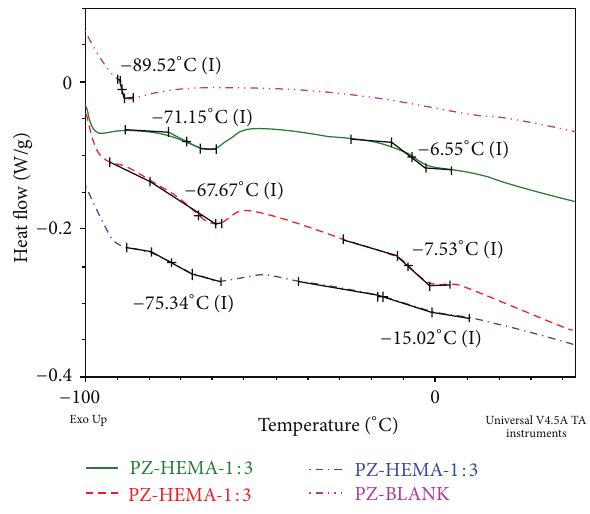
Figure 6: DSC Thermograms of PZ, PZ-HEMA-1:3, PZ-HEMA- 1:6, and